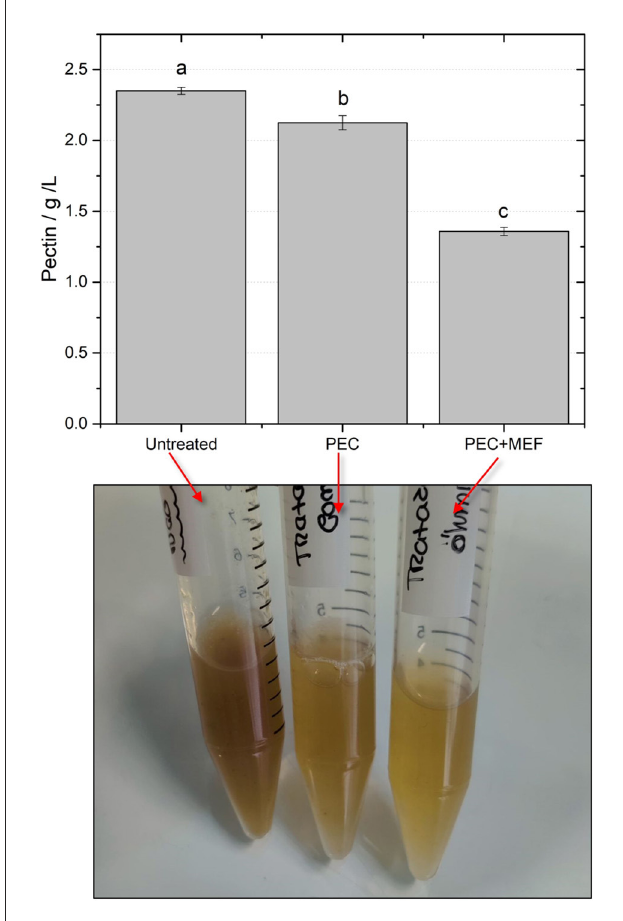
FIGURE4 Pectin concentration of Vinho Verde must samples just before the addition of PEC (untreated) and after PEC treatment at 20 ◦ C, without MEF application (PEC sample) and assisted by MEF at 7 V/cm and 20kHz (PEC + MEF sample). Different letters correspond to the statistical difference ( p < 0.05) between